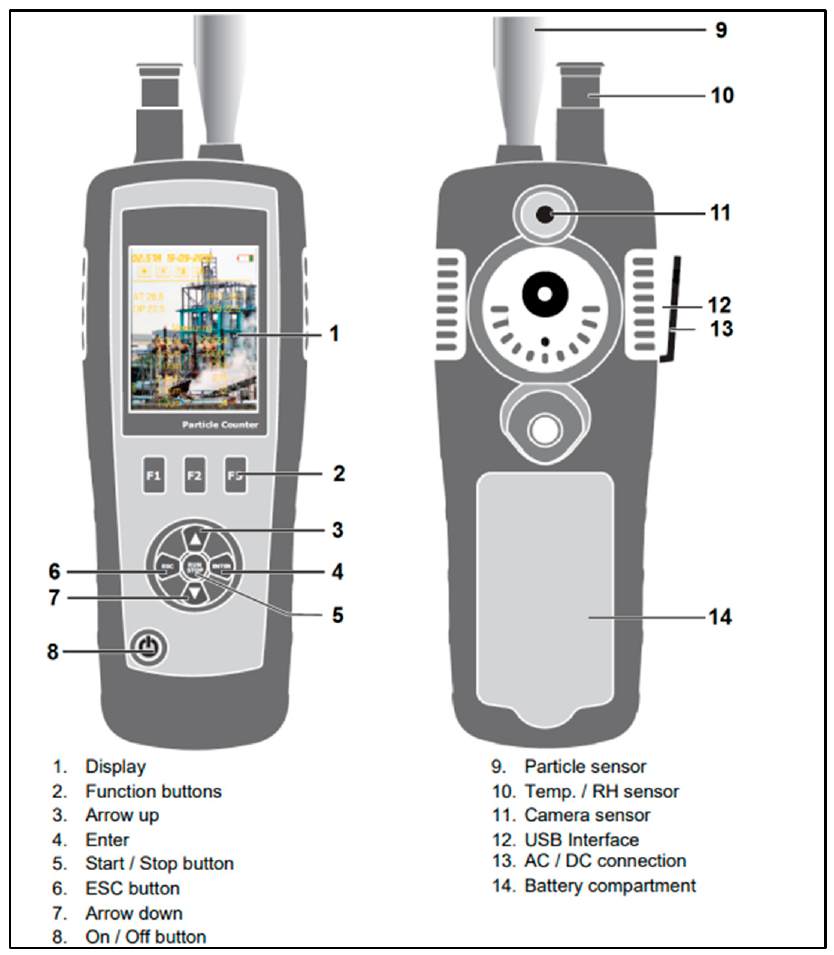
Figure 3. PCE-PCO 2 measuring device [43].